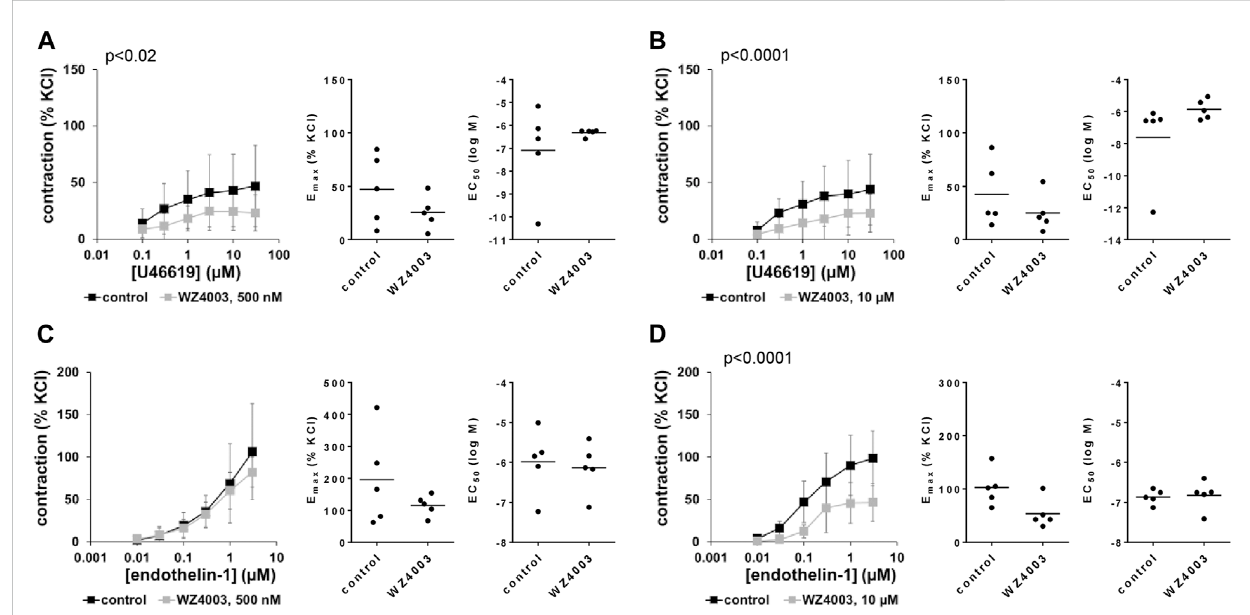
FIGURE 11 Effects of WZ4003 on non-adrenergic contractions of human prostate tissues. Contractions of human prostate tissues were induced by U46619 (A,B) or endothelin-1 (C,D) in an organ bath, 30 min after addition of WZ4003 in concentrations of 500 nM (A,C) or 10 µM (B,D) or of an equivalent amount of DMSO (controls), which was used as solvent for WZ4003. Shown are data from n = 5 independent experiments in each subpanel, where tissues from n = 5patients wereused for both groups of asubpanel, resulting inpaired samples. Shown are means± SD from all experiments in concentration response curves with p values from two-way ANOVA for whole groups, and all single E max and EC 50 values from all experiments (calculated by curve fi tting) in scatter